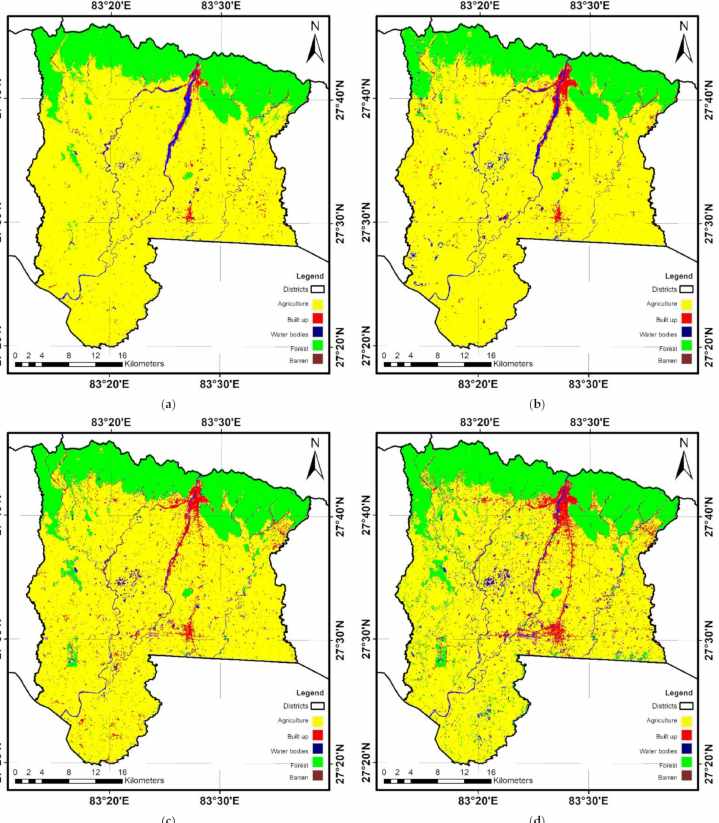
Figure 6. Results of land cover (LC) mapping for different years via GEE: ( a ) 2005; ( b ) 2010; ( c ) 2015; and ( d )